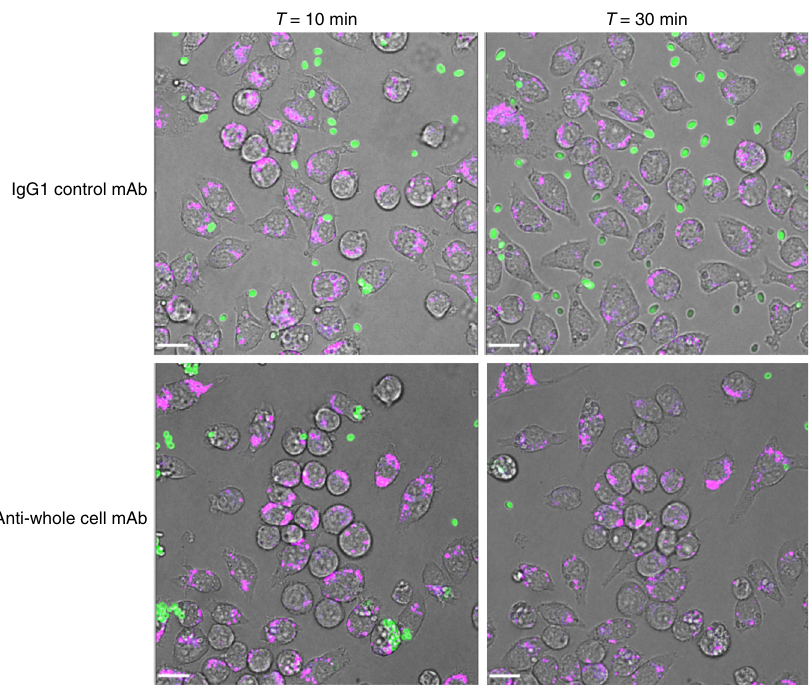
Fig. 9 Effect of anti- Candida mAbs on macrophage phagocytosis of live C . auris cells. Snapshot images taken from live cell video microscopy capturing C. auris phagocytosis by J774.1 macrophages at T = 10 min and T = 30 min following pre-incubation of C. auris cells with IgG1 control antibody or anti-whole cell reactive antibody. Macrophages (magenta), C. auris (green). The scale bars represent 18 µ